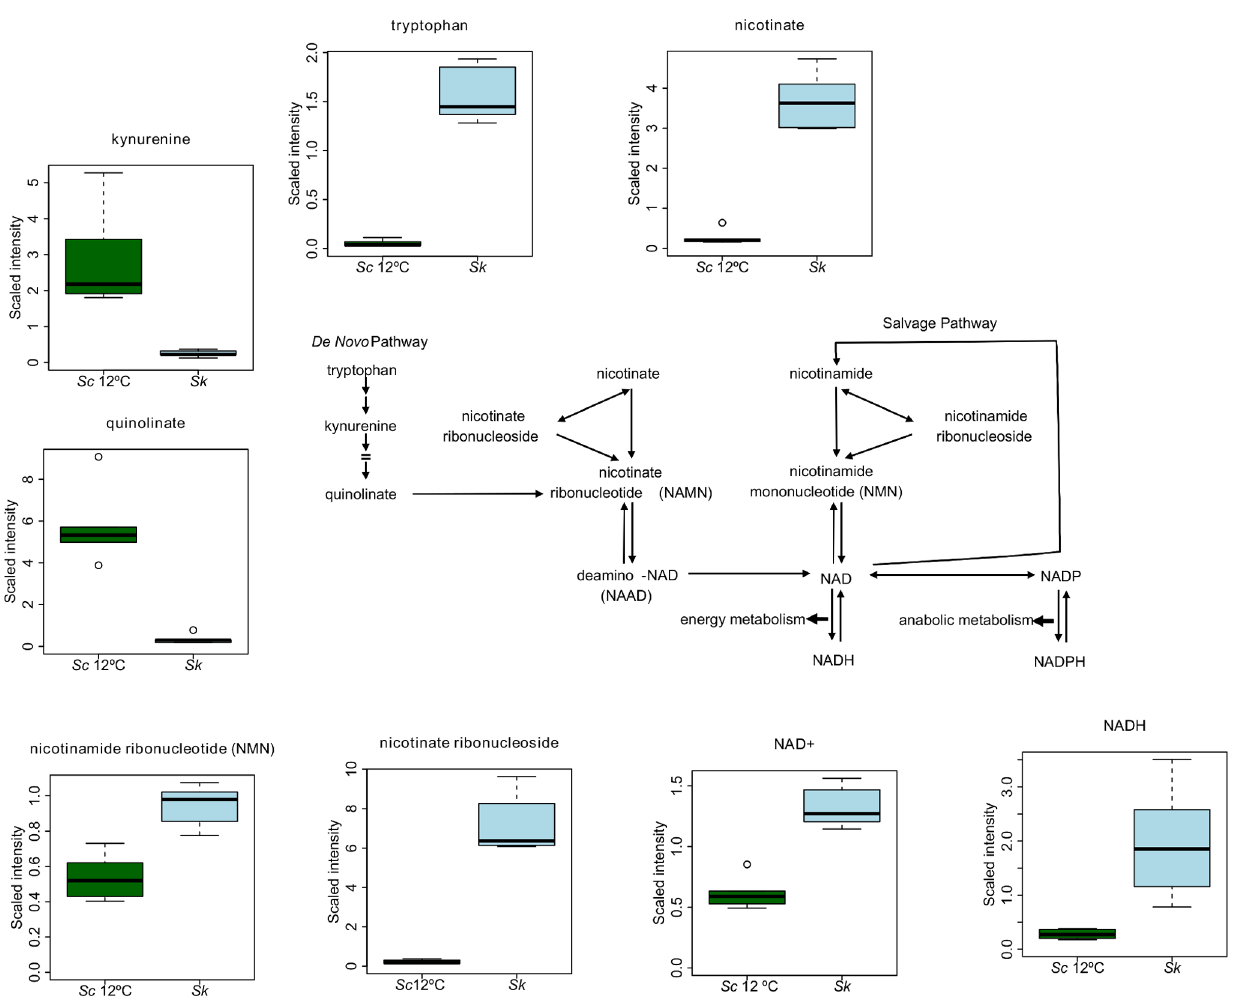
Figure 8. The NAD + biosynthesis pathway. Differentially produced metabolites within Sk and Sc . Box legend: bar inside the box represents the median value, upper bar represents maximum of distribution, lower bar represents minimum of distribution and the circle represents extreme data points.